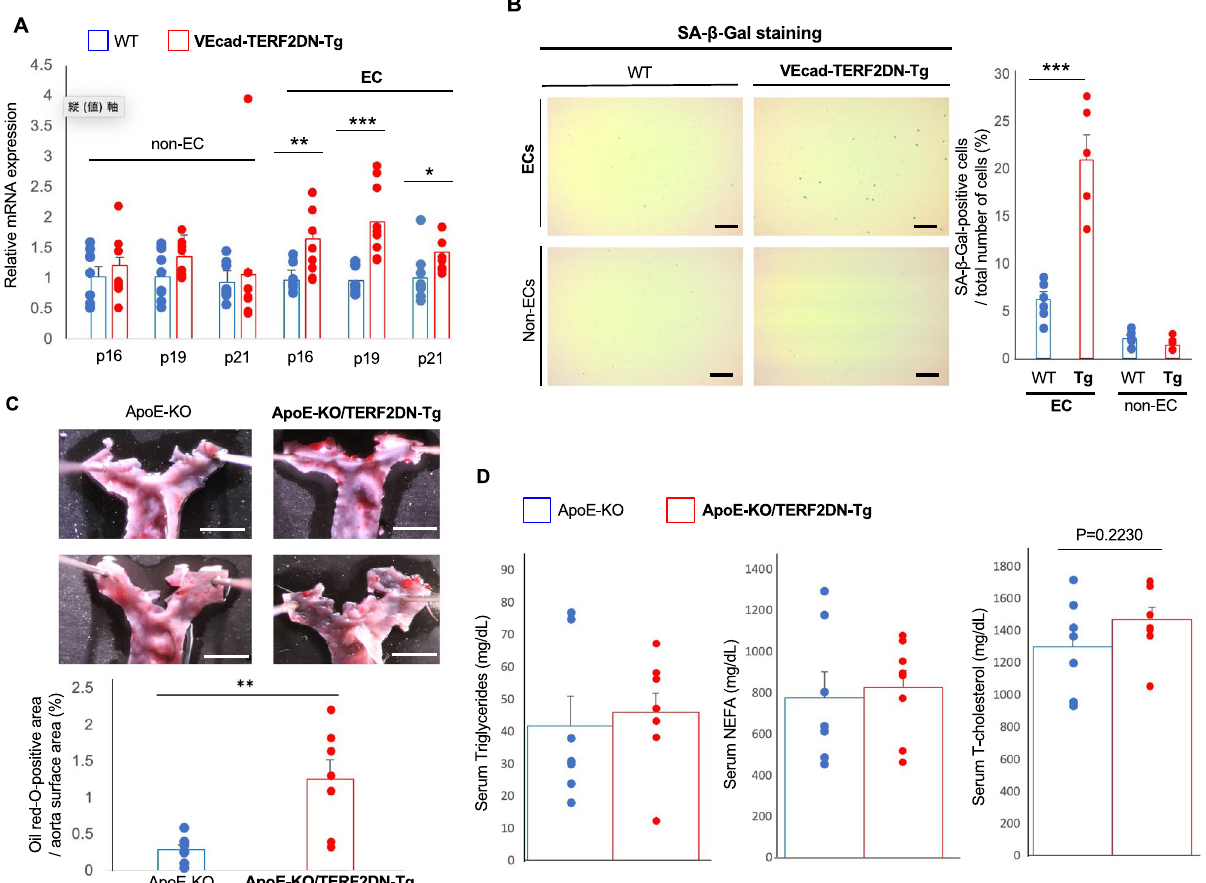
Figure 2. Validation of accelerated atherosclerosis using a new line of EC-specific progeroid mouse. ( A ) CDK inhibitors expression in EC and non-EC isolated from the lungs of WT and VEcad-TERF2DN-Tg mice (n = 9 each). ( B ) SA-β-Gal staining in ECs and non-ECs isolated from the lungs of WT or VEcad-TERF2DN-Tg mice. The number of SA-β-Gal-positive cells was counted (n = 6). Bars: 100 μm. ( C ) Typical images for oil red-O staining of enface thoracic aorta isolated from ApoE-KO and ApoE-KO/VEcad-TERF2DN-Tg mice fed high cholesterol diet for 2 weeks are shown. Atherosclerotic plaque formation was enhanced in EC-specific progeroid mice (n = 7 each). Bars: 2 mm. ( D ) Serum lipid profiles in ApoE-KO and ApoE-KO/VEcad-TERF2DN-Tg mice fed high cholesterol diet for 2 weeks (n = 7 for ApoE-KO; n = 8 for ApoE-KO/TERF2DN-Tg). Data are presented as mean ± SEM. * p < 0.05, ** p < 0.01, and *** p <